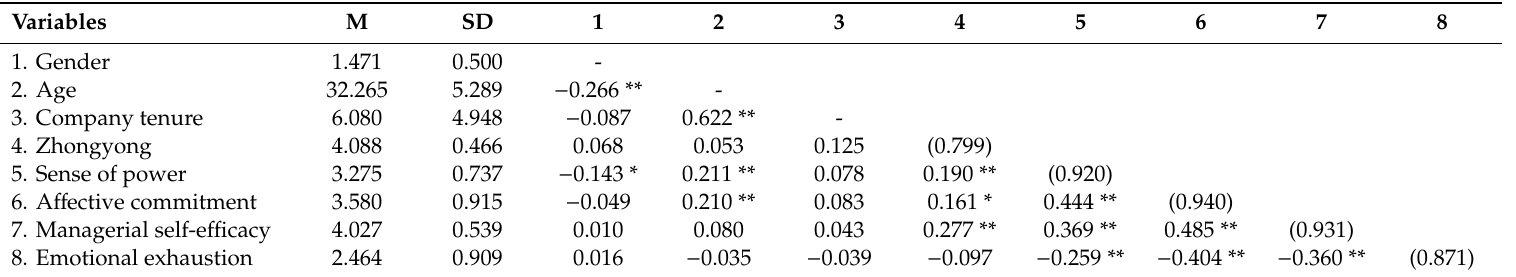
Table 2. Descriptive statistics, correlations, and reliability